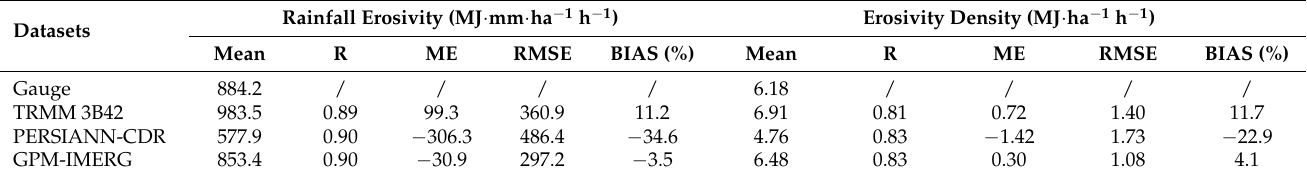
Table 1. Performance comparison of the three SPPs for rainfall erosivity and erosivity density on the monthly